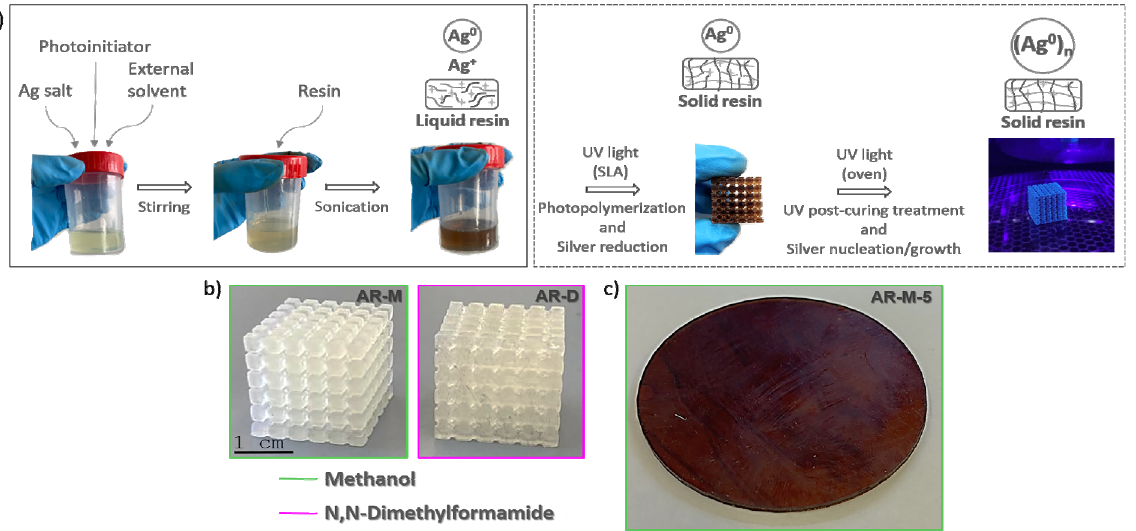
Figure 2. ( a ) Scheme depicting the process followed to prepare 3D printed nanocomposites using SLA (the box with continuous line includes the steps that are common with the method based in melds as explained above, and the dashed box shows the specific steps for the SLA method); ( b ) printed cubes of the solutions containing the mixture of unfilled resin with methanol (green) and DMF (purple); ( c ) disk printed by SLA of the solution containing methanol and 5 wt% AgClO 4 .